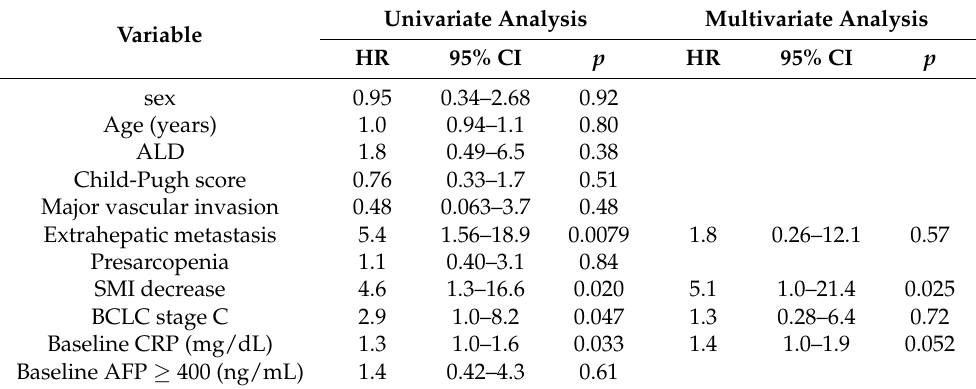
Table 4. Univariate and multivariate of PFS.